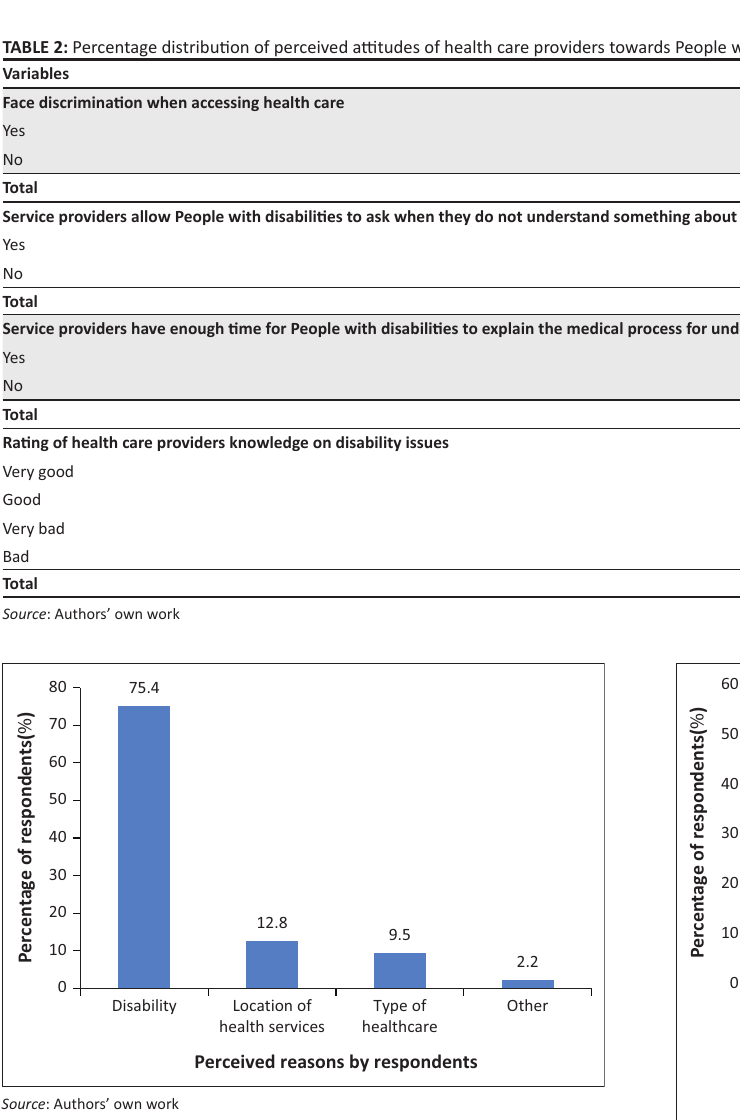
FIGURE 1: Basis for discrimination against people with disabilities.